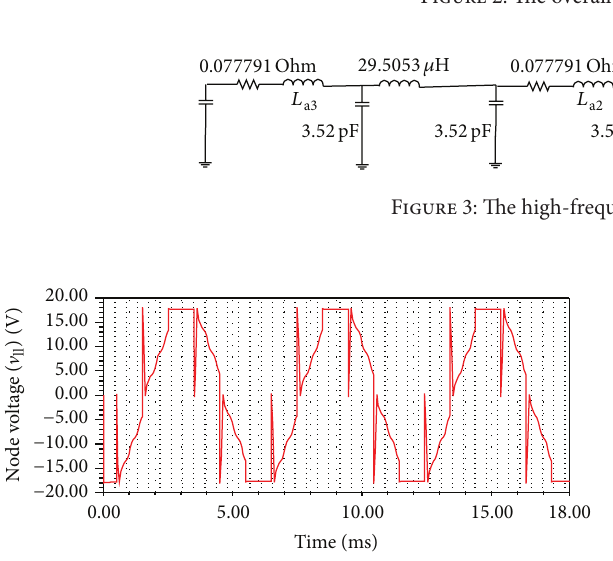
Figure 2: The overall high-frequency model.